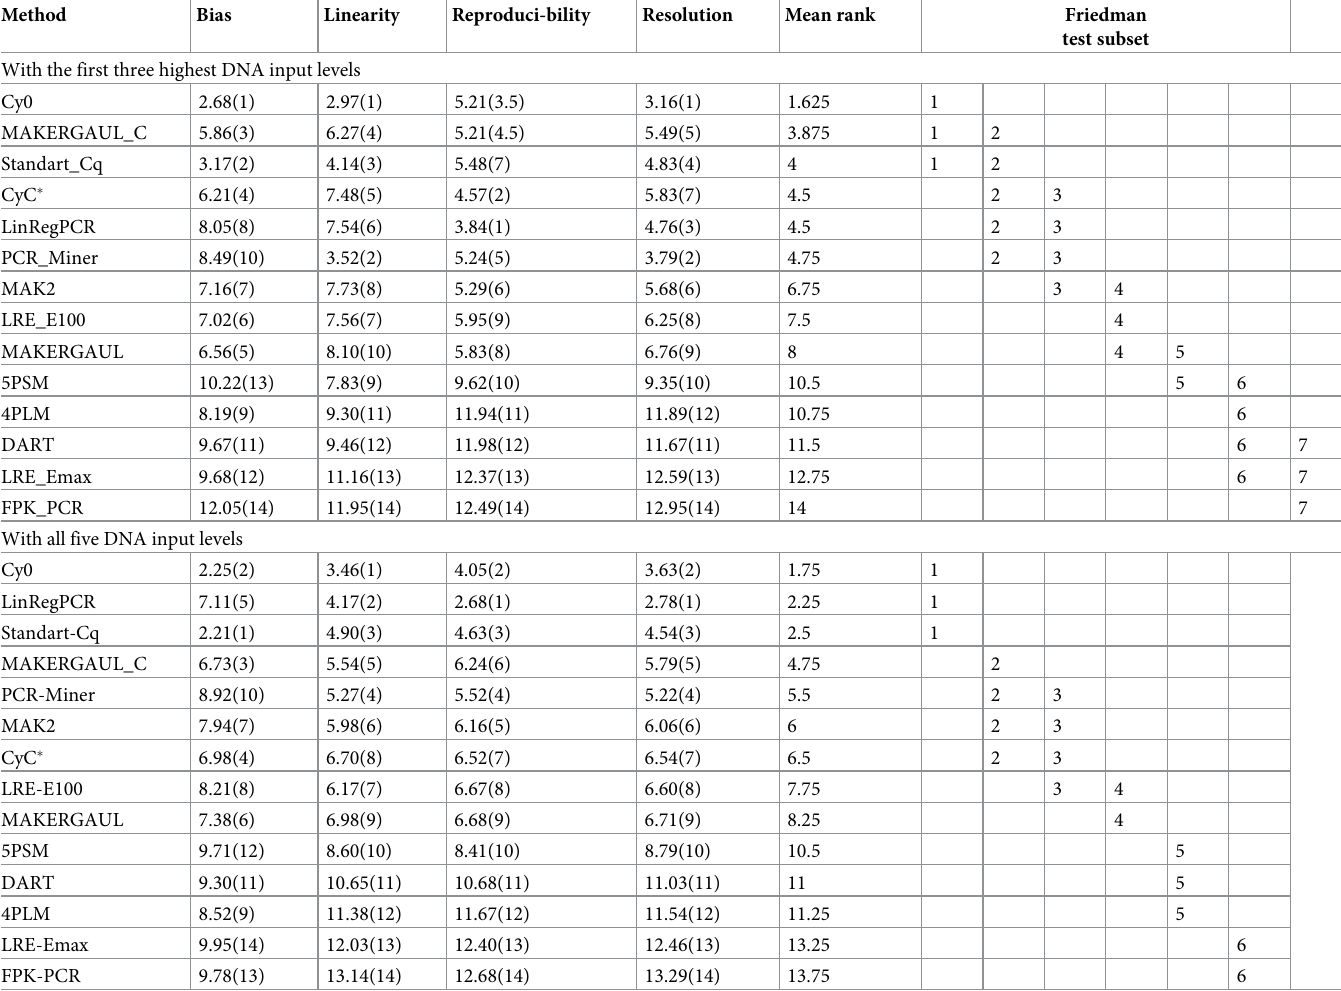
Table 2. Comparative performance analysis of CyC � using public